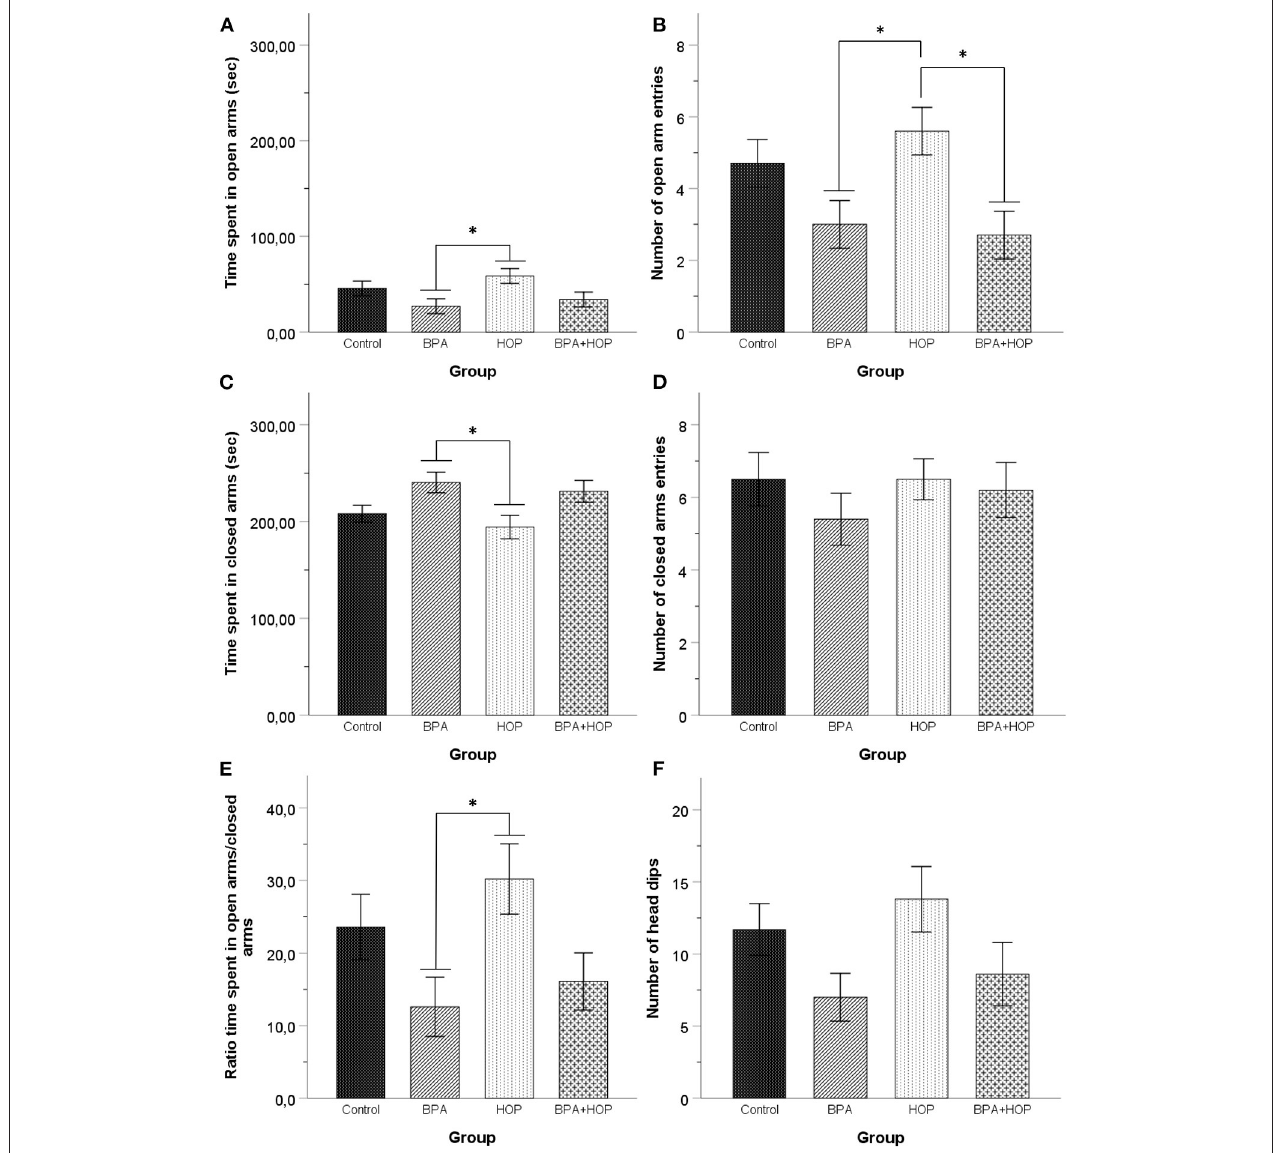
FIGURE 4 | All rats were tested in the elevated plus maze on PND 54 (Control: n = 10; BPA: n = 10; Hop: n = 11; BPA-Hop: n = 10). Rats in the BPA and the Hop groups differed significantly in (A) time spent in open arms; (B) number of open arm entries; (C) time spent in closed arms. However, (D) they did not differ in the number of closed arm entries. (E) The ratio of time spent in the open over closed arms was calculated using the ratio of time spent in closed arms over the total amount of time recorded in both open and closed arms. BPA-treated rats spent a significantly smaller time ratio in the open arms compared to the Hop group. (F) There was no between-group differences in the number of head dips. Data are represented as mean ± SEM. * p <